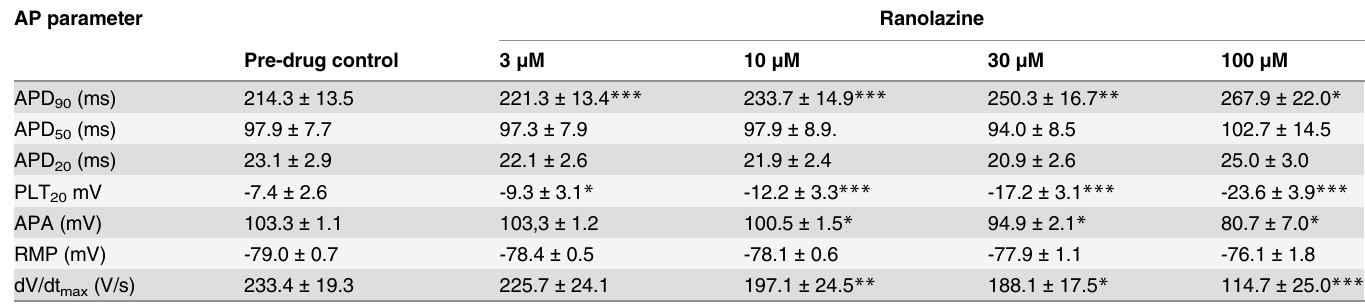
Table 3. Effects of ranolazine on human right atrial action potential parameters (1 Hz) from patients in atrial fibrillation (AF), n = 7. AP parameter